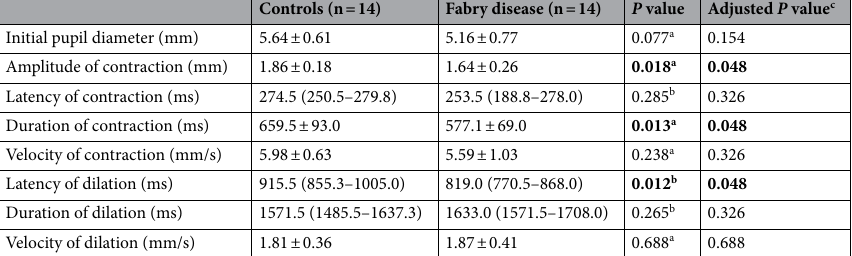
Table 2. Pupillary light reflex responses in patients with Fabry disease and healthy control subjects. Data are expressed as mean ± SD for parametric variables and median (IQR) for non-parametric variables. The bold P values represent statistically significant differences. a Independent samples t-test. b Mann Whitney U-test. c P values were adjusted using a Benjamini–Hochberg false discovery rate (FDR) correction